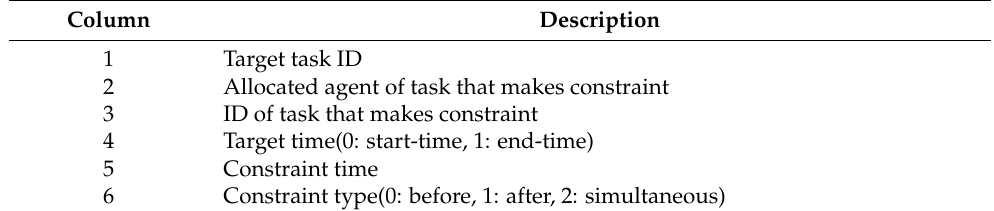
Table 6. Contents of constraint